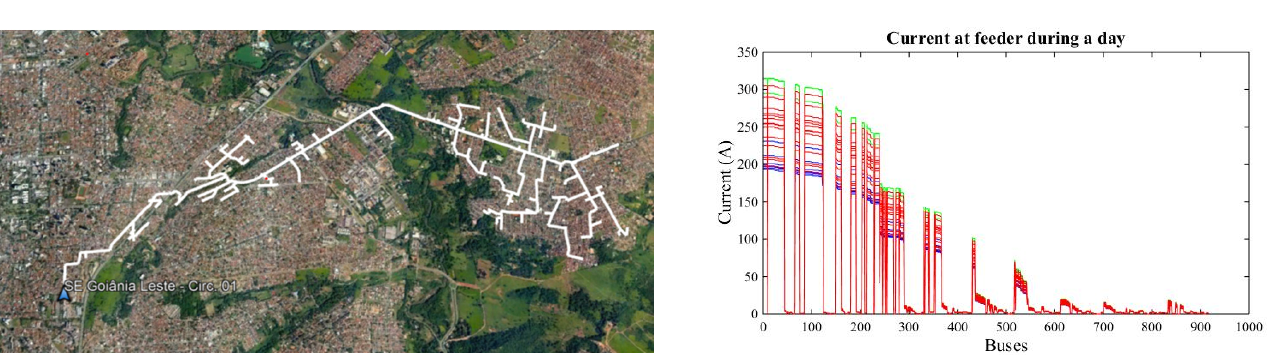
Figure 5. Feeder picture (on Google Earth) and feeder current during a day for case II.